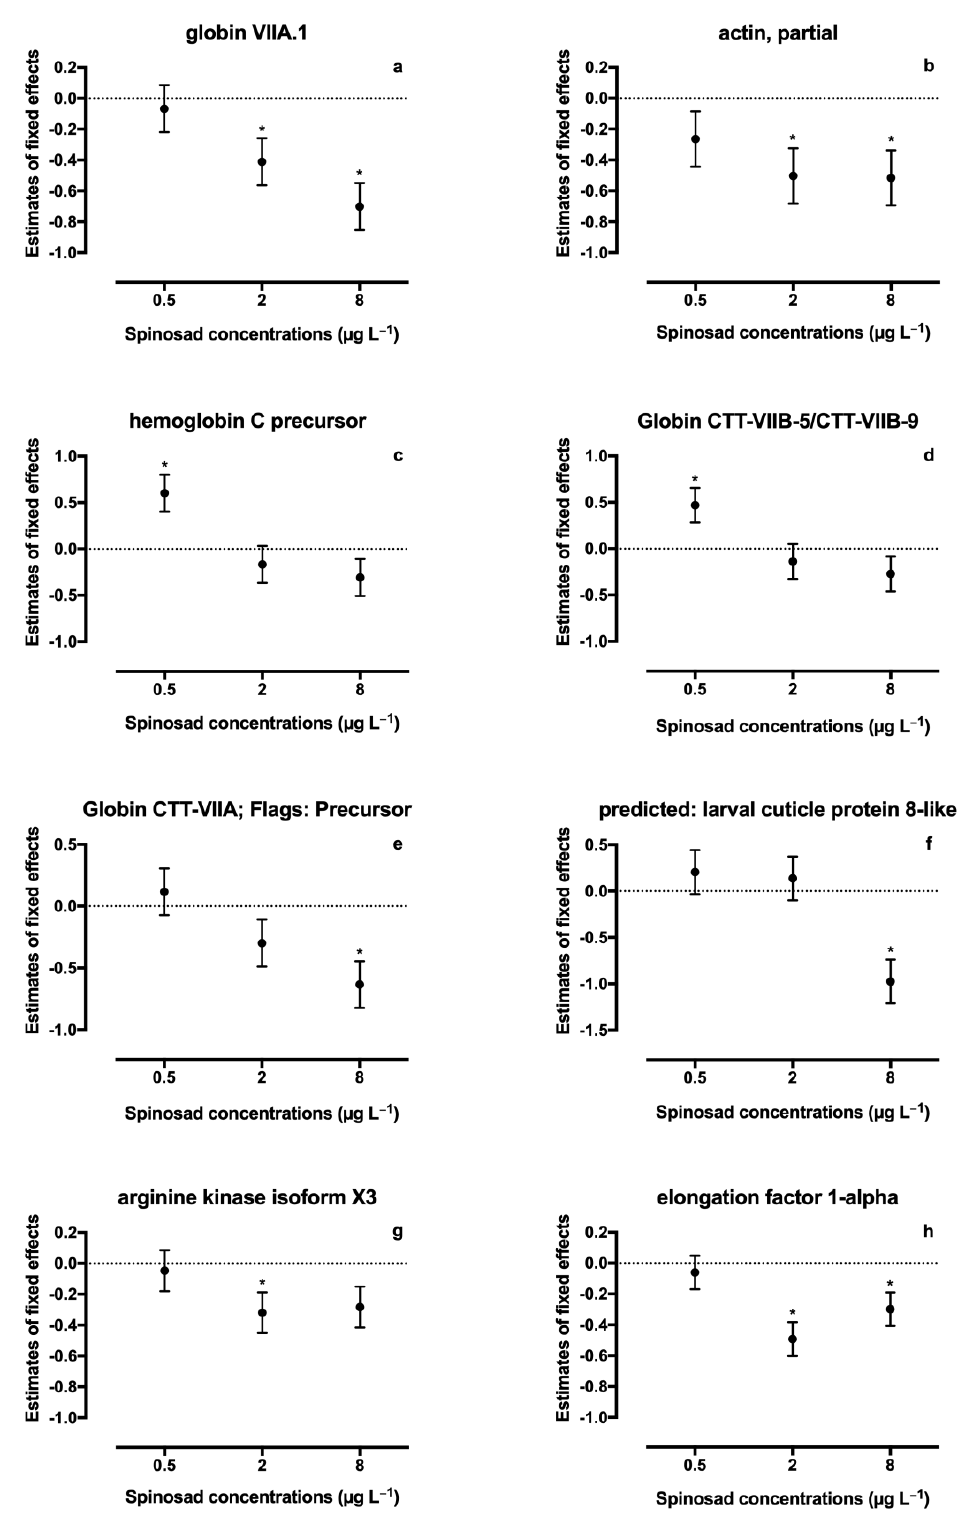
Figure 1. Changes in proteins abundance in Chironomus riparius after exposure to Spinosad. Plots are presented as estimates of fixed effects ± SE from linear mixed model. Asterisks indicate significant differences; ( a ) globin VIIA.1; ( b ) actin, partial; ( c ) hemoglobin C precursor; ( d ) globin CTT-VIIB-5 / CTT-VIIB-9; ( e ) globin CTT-VIIA; flags: precursor; ( f ) predicted: larval cuticle protein 8-like; ( g ) arginine kinase isoform X3; and ( h ) elongation factor 1-alpha.